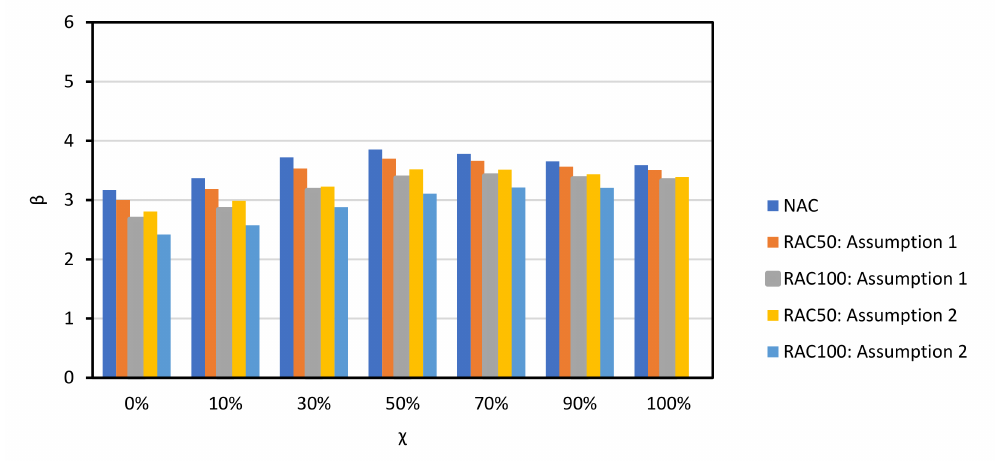
Figure 8. χ vs. β for shear resistance design of NAC and RAQ beams with shear